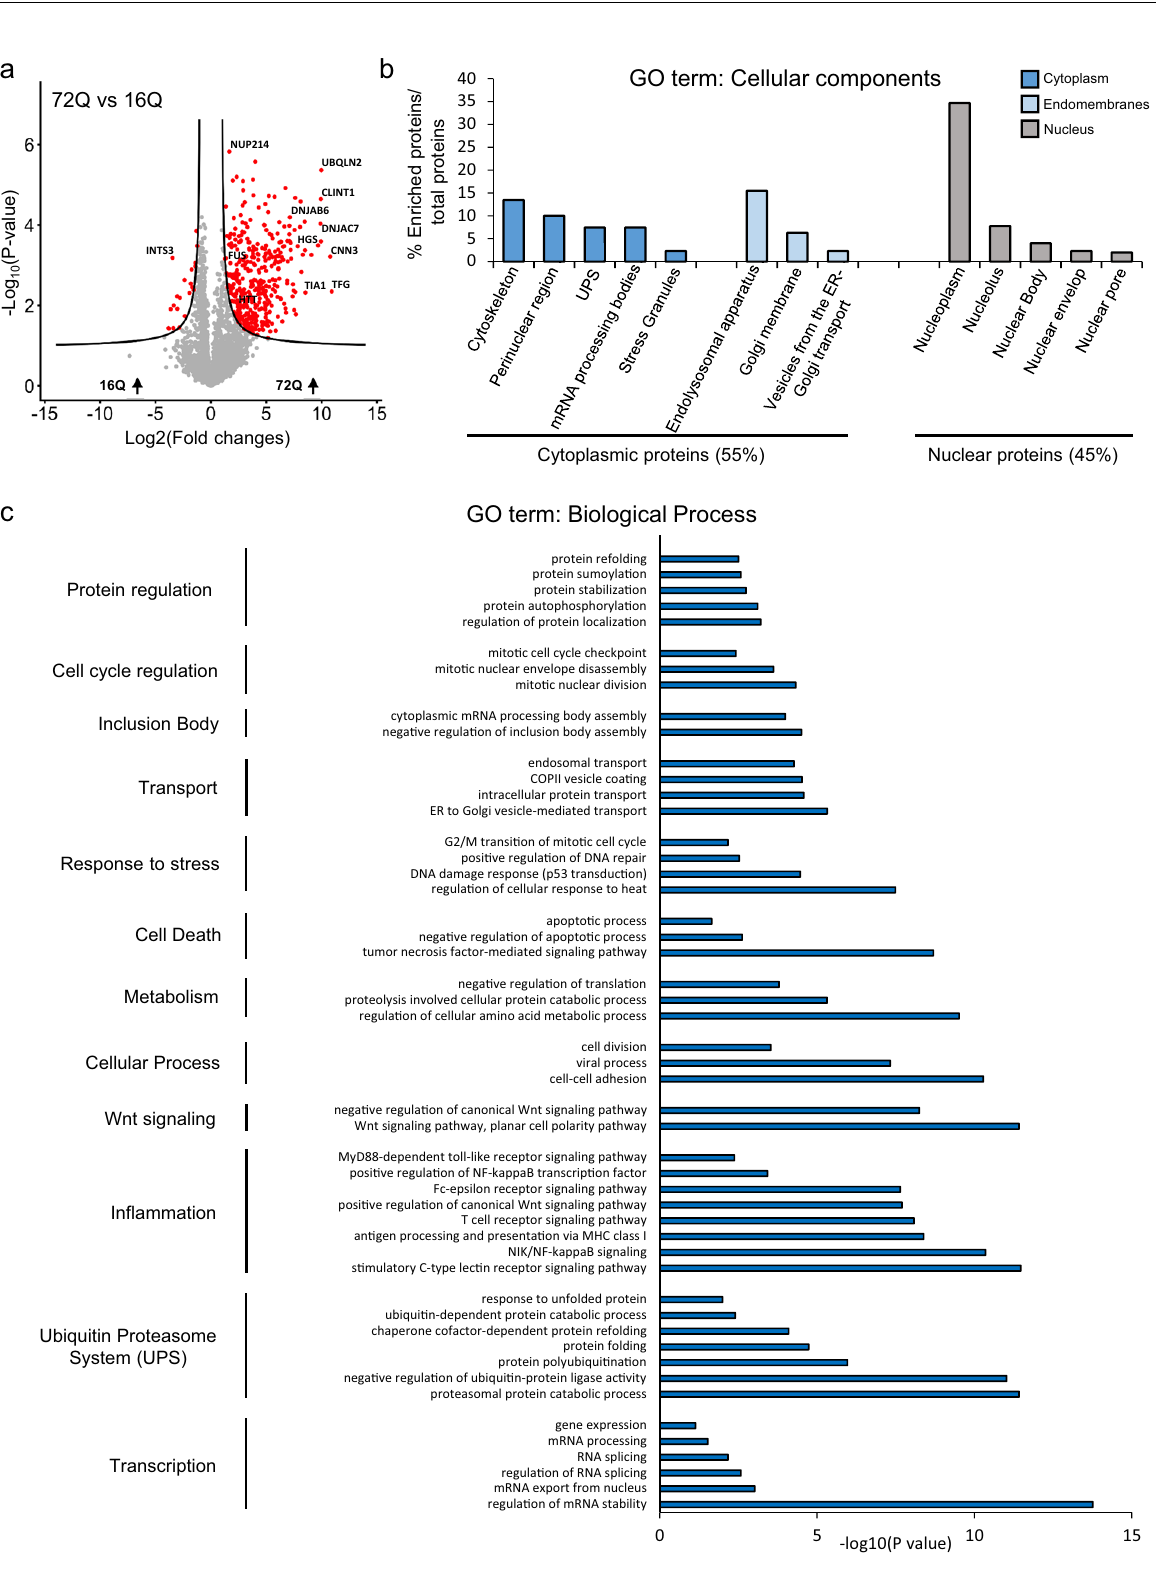
adhesionviral pathwaycell-cell